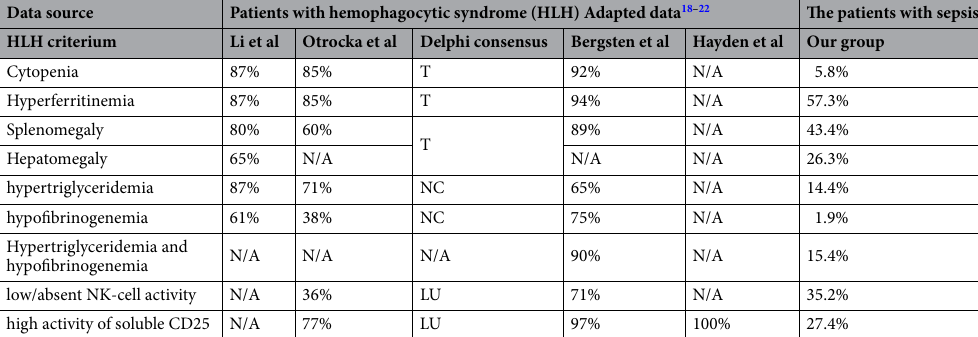
Table 6. Prevalence of particular HLH syndrome criteria in the studied group of patients with sepsis (n = 104) and in other studies, including patients with real HLH syndrome (Adapted data 18–22 ). N/A – not applicable, T – typical for HLH, NC – no consensus, LU – of little use in everyday